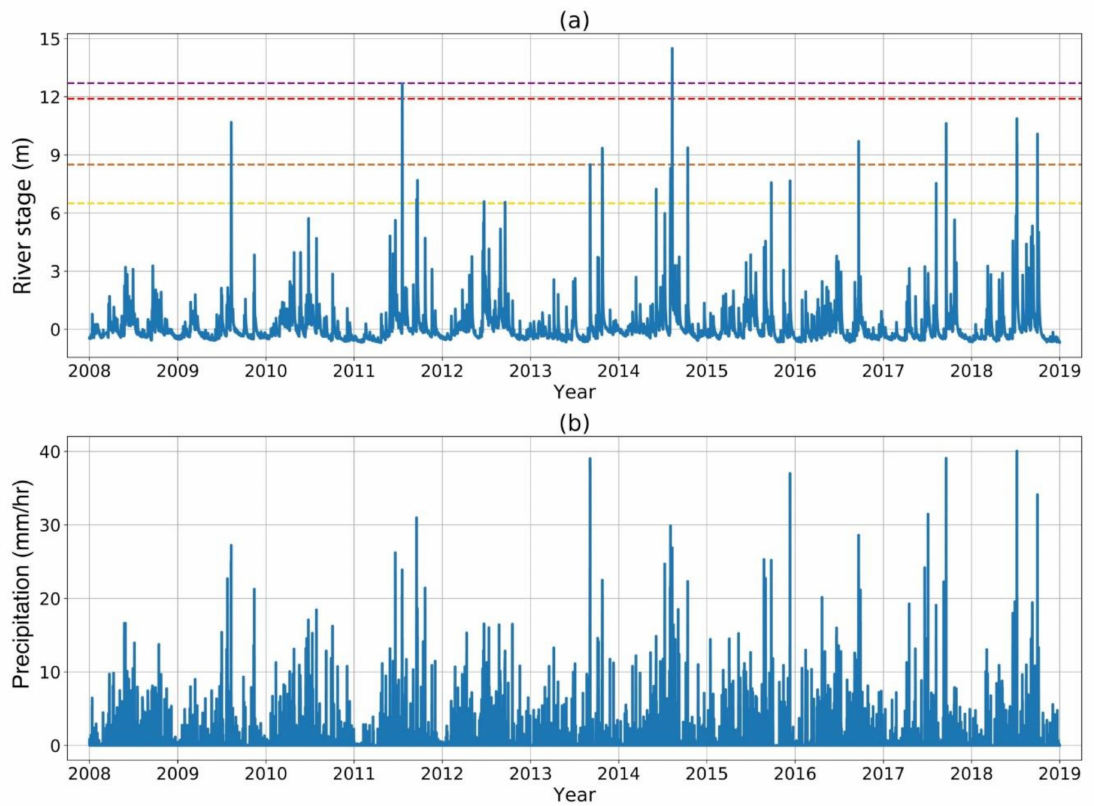
Figure 2. Observational data of ( a ) river stages at Tsunokawa Observatory, and ( b ) mean precipitation of the 13 rain gauges. The yellow dashed line indicates the stage at which the flood prevention team are put on standby (6.50 m). The orange dashed line is the stage for flood warning (8.50 m), the red is the level for evacuation judgement (11.90 m), and the purple is the flood danger level (12.70